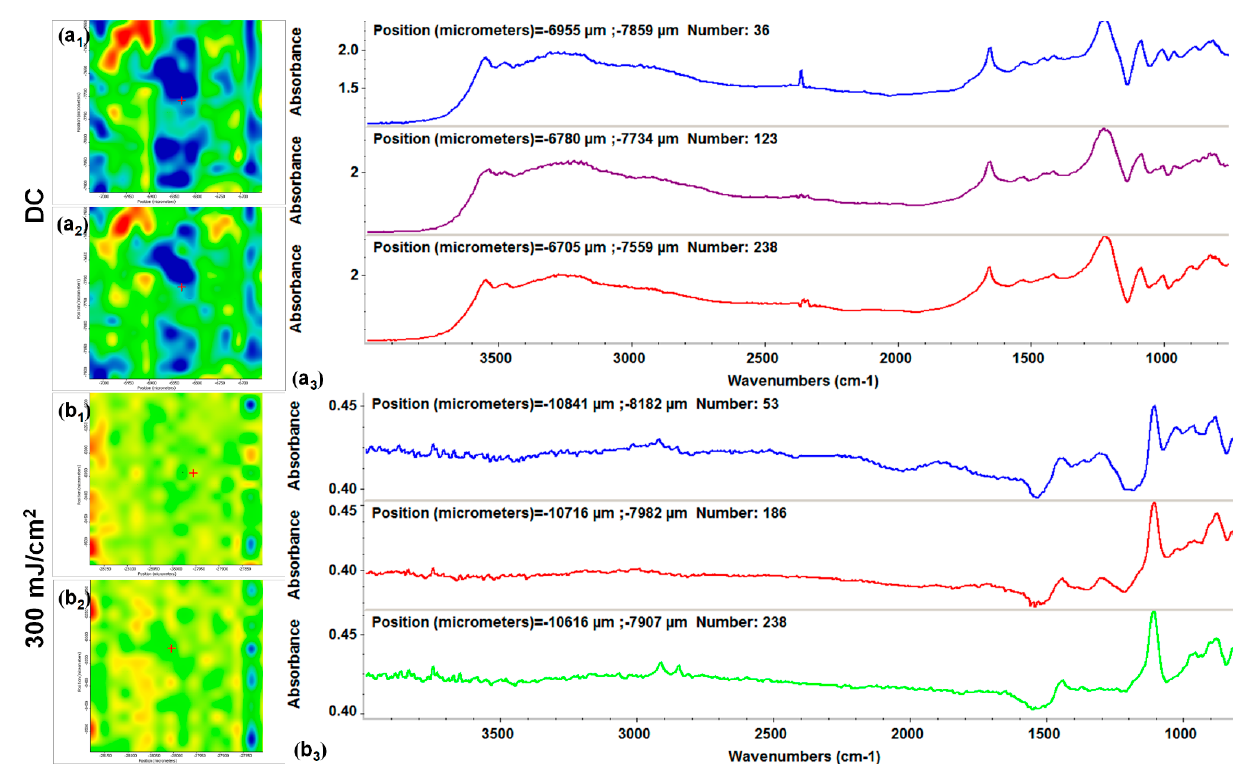
Figure 4. IR maps assigned to the distribution of phosphate ( a 1 , b 1 ) and methylene ( a 2 , b 2 ) groups and IR spectra of dropcast ( a 3 ) and HAp/KAN/FGF2 (fibroblast growth factor 2) coatings obtained at 300 mJ/cm 2 laser fluence ( b 3 ) .